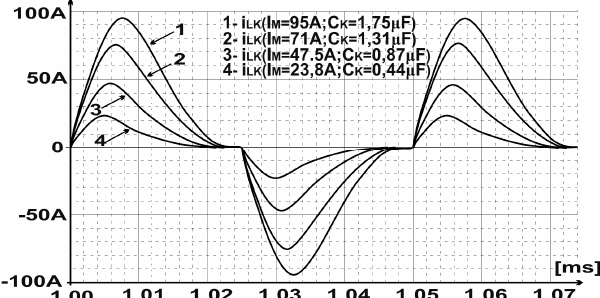
Figure 12. The current through AC diagonal of AI with ED at different dosing capacitor: 1–100% P RATED ; 2–75% P RATED ; 3–50% P RATED ; 4–25% P RATED .